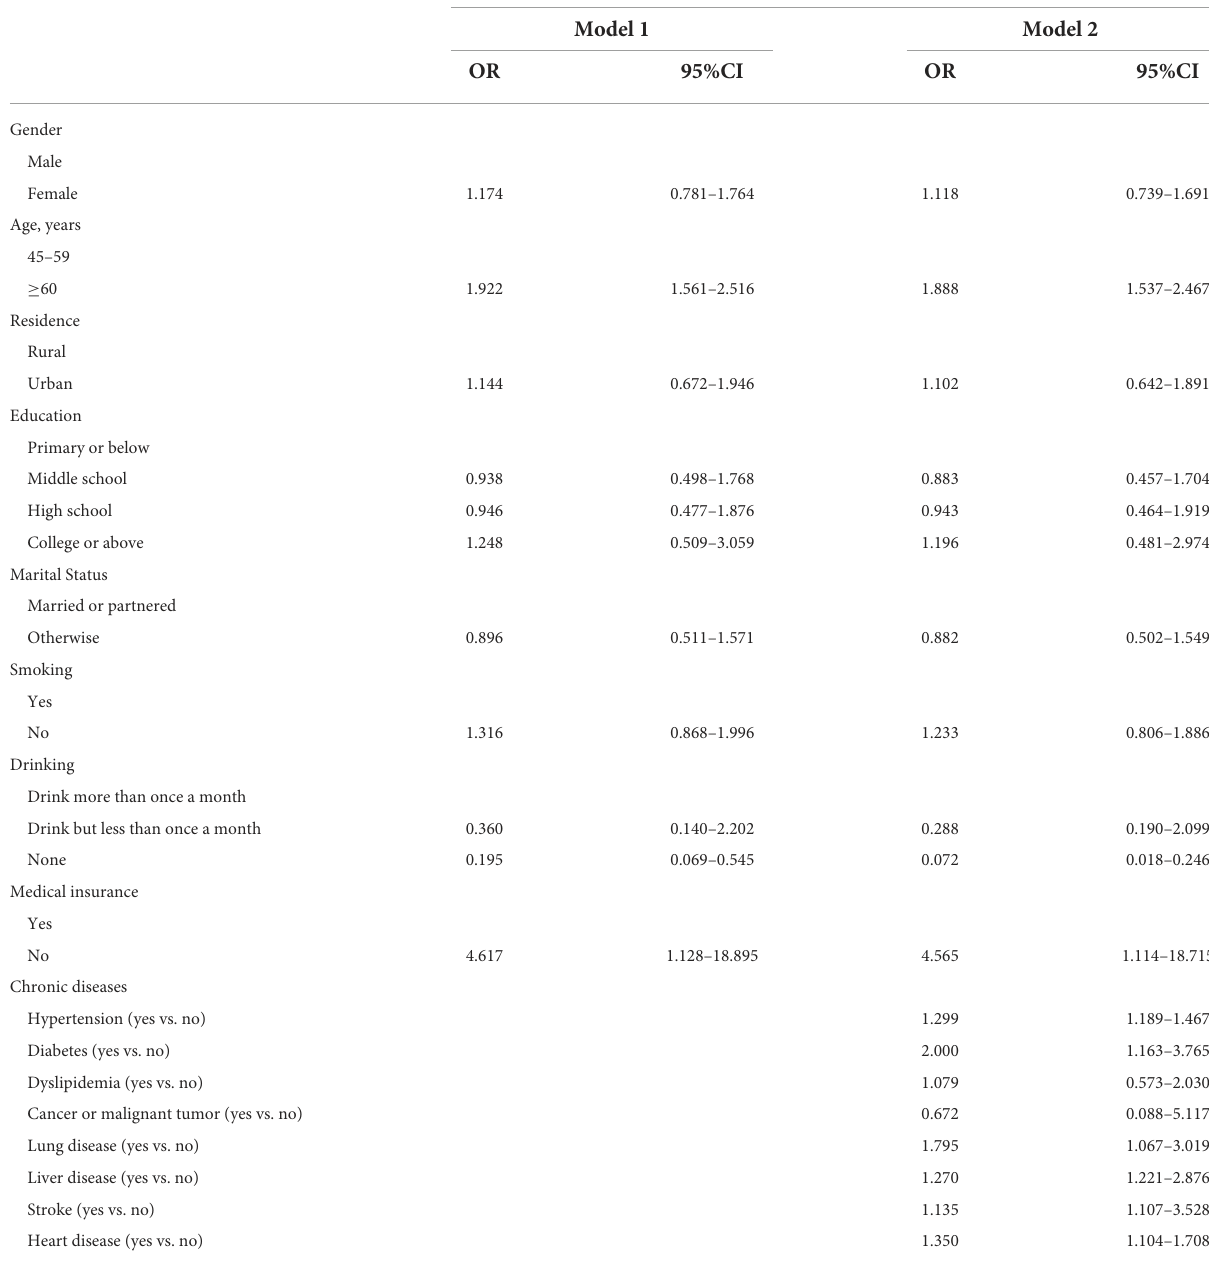
TABLE 3 Cross-sectional analysis of visual impairment with different variables in different